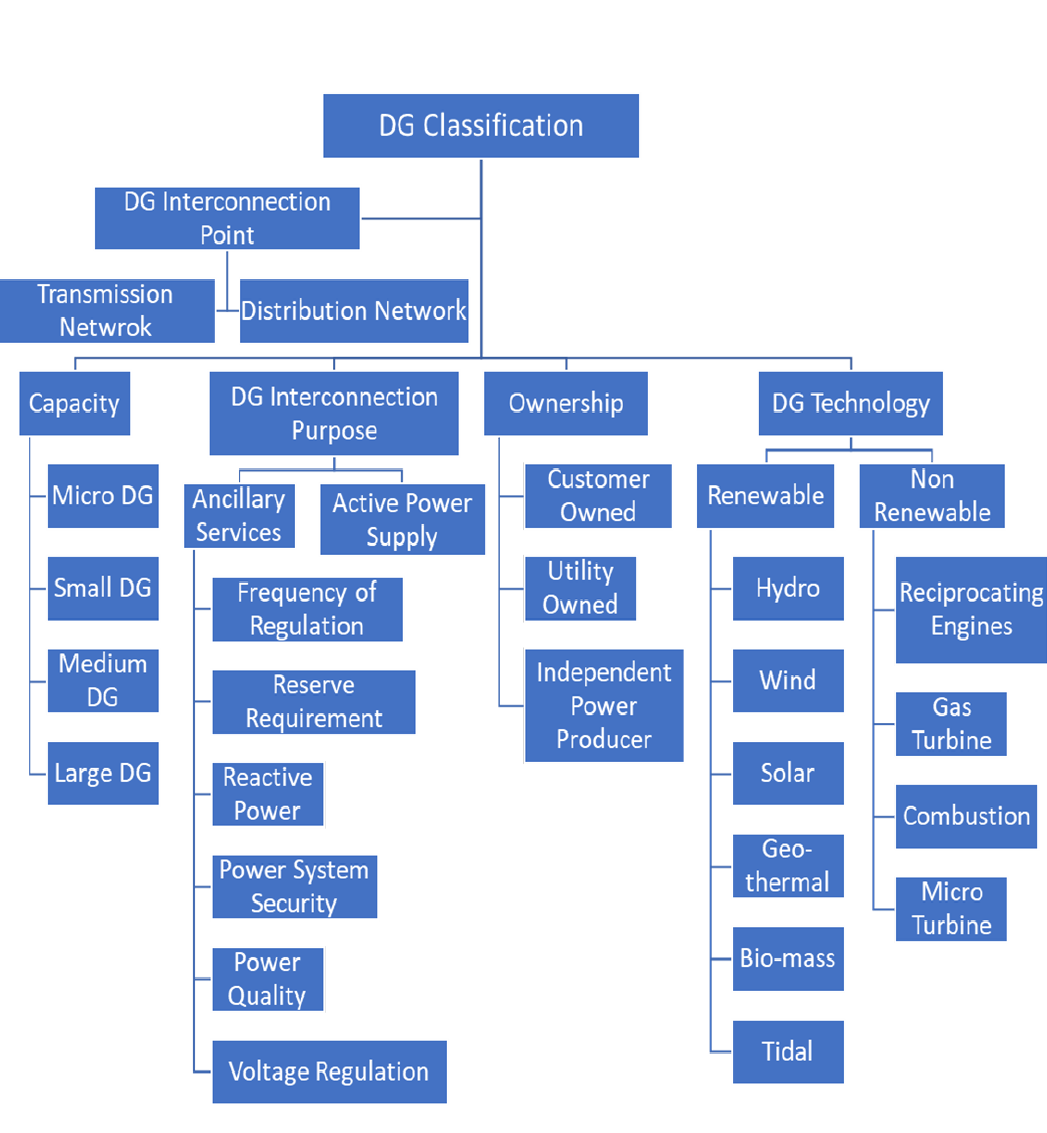
Figure 1. Classification of